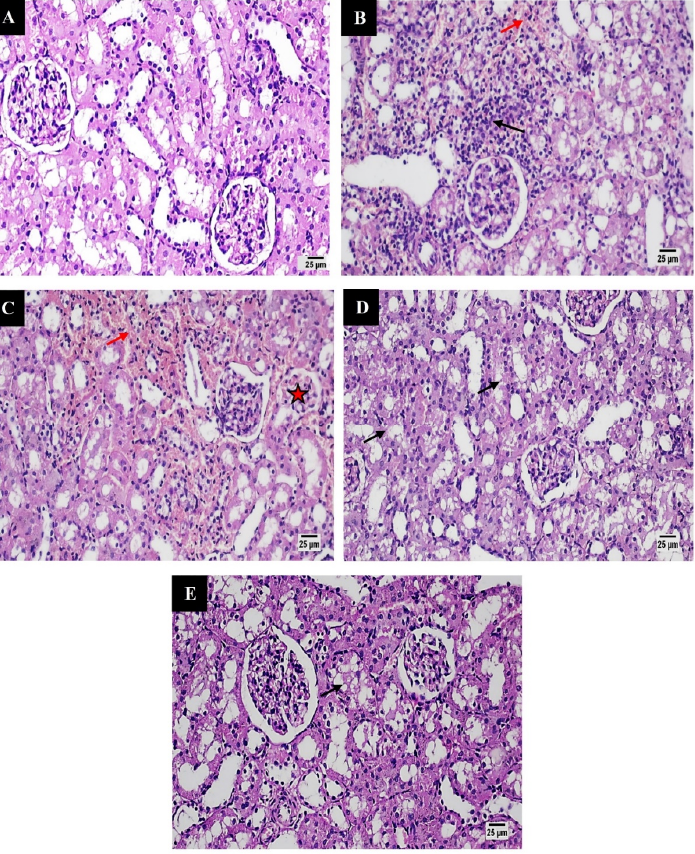
Figure 16. Photomicrographs of H&E-stained sections of kidney. ( A ) Control rat sample showing normal histology of renal cortex. ( B , C ) The diabetic rat group sample showing degenerating renal tubules with mononuclear inflammatory cells infiltration (black arrow), interstitial haemorrhage (red arrows), and deformity of renal corpuscle with atrophy of glomerular capillaries (red star). ( D ) MTF- treated group sample showing vacuolation in the renal tubular epithelium (arrows). ( E ) MTF-loaded LCS-ALG bead-treated group sample showing enhancement along with mild vacuolation in the renal tubular epithelium (arrow) with normal renal